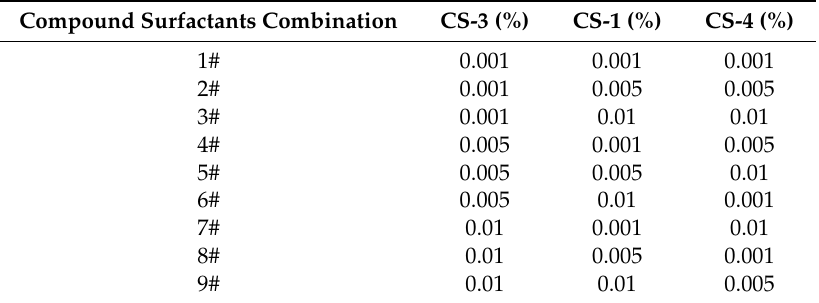
Table 6. Experiment design of compound surfactants via orthogonal methods.